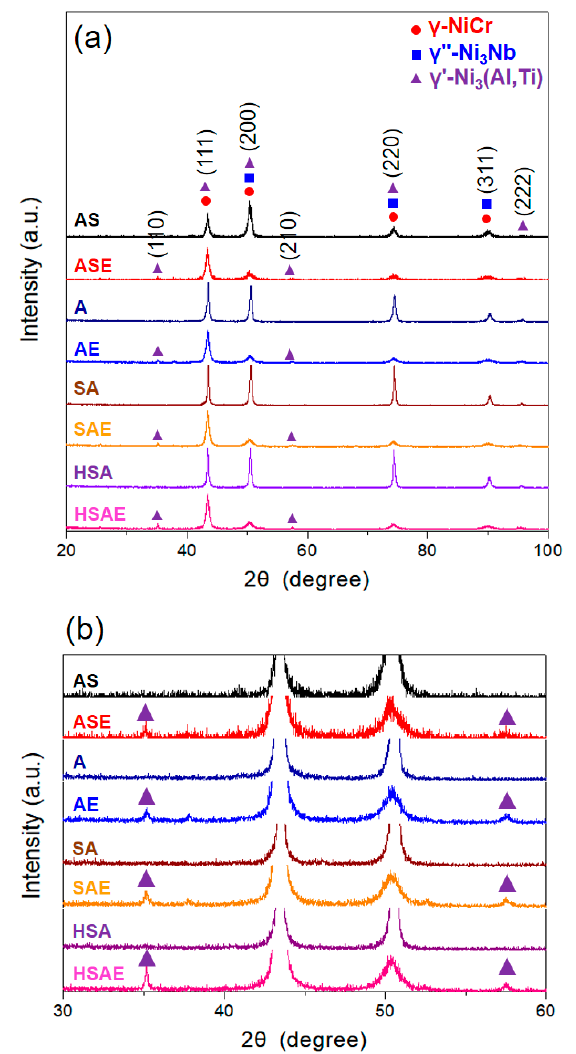
Figure 9. X-ray di ff raction pattern of AS, A, SA, and HSA pre and post erosion: ( a ) 20–100 ◦ , and ( b ) Figure 9. X-ray diffraction pattern of AS, A, SA, and HSA pre and post erosion: ( a ) 20–100°, and ( b ) 30–60 ◦ 30–60°.